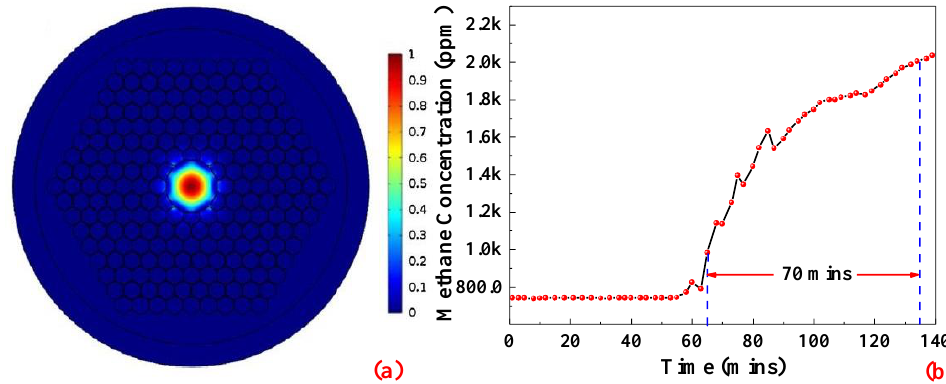
Figure 5. Simulation test of the optical structure ( a ) and the diffusion test of standard gas ( b ).